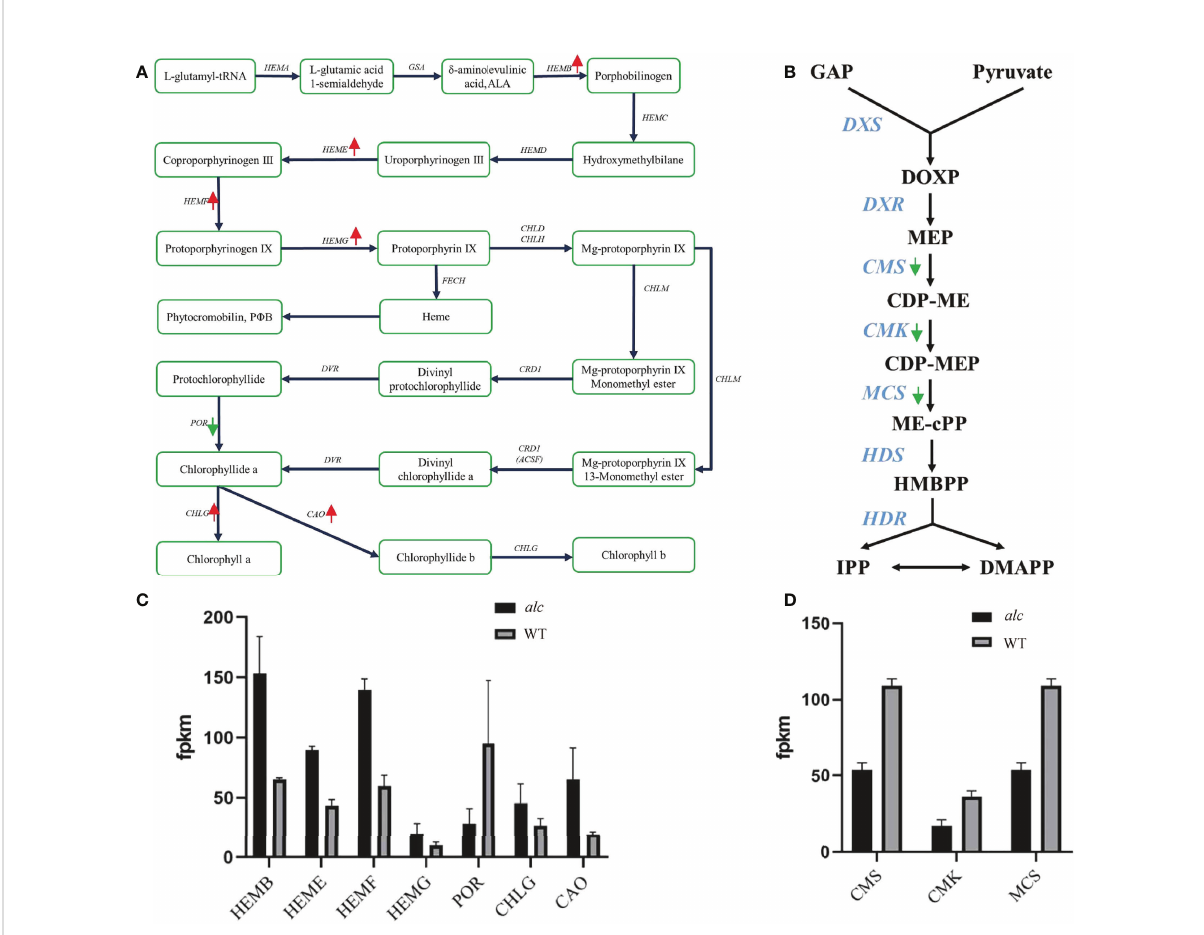
FIGURE 5 Differential expression of genes involved in chlorophyll metabolism and Methylerythritol 4-phosphate (MEP) pathway. (A, B) Diagram showing major genes in chlorophyll metabolism and MEP pathway, respectively. Red arrows indicated up-regulated genes and green arrows indicated down-regulated genes in alc mutant. (C, D) Expression pro fi le of DEGs in chlorophyll metabolism and MEP pathway achieved by RNA-seq. The mean FPKM (fragments per kilo base of transcript per million mapped reads) values for the DEGs were calculated from three biological replicates for each genotype. Error bars indicated standard deviations. GAP, glyceraldehyde-3-phosphate; DOXP, 1-deoxy-D-xylulose-5- phosphate; MEP, 2-C-methyl-D-erythritol-4-phosphate; CDP-ME, 4-diphosphocytidyl-2-C-methyl-D-erythritol; CDP-MEP, 4- diphosphocytidyl-2-C-methyl-D-erythritol-2-phosphate; ME-cPP, 2-C-methyl-D-erythritol-2,4-C-cyclodiphosphate; HMBPP, 1-hydroxy-2- methyl-2-(E)-butenyl-4-diphosphate; IPP, isopentenyl diphosphate DMAPP, dimethylallyl